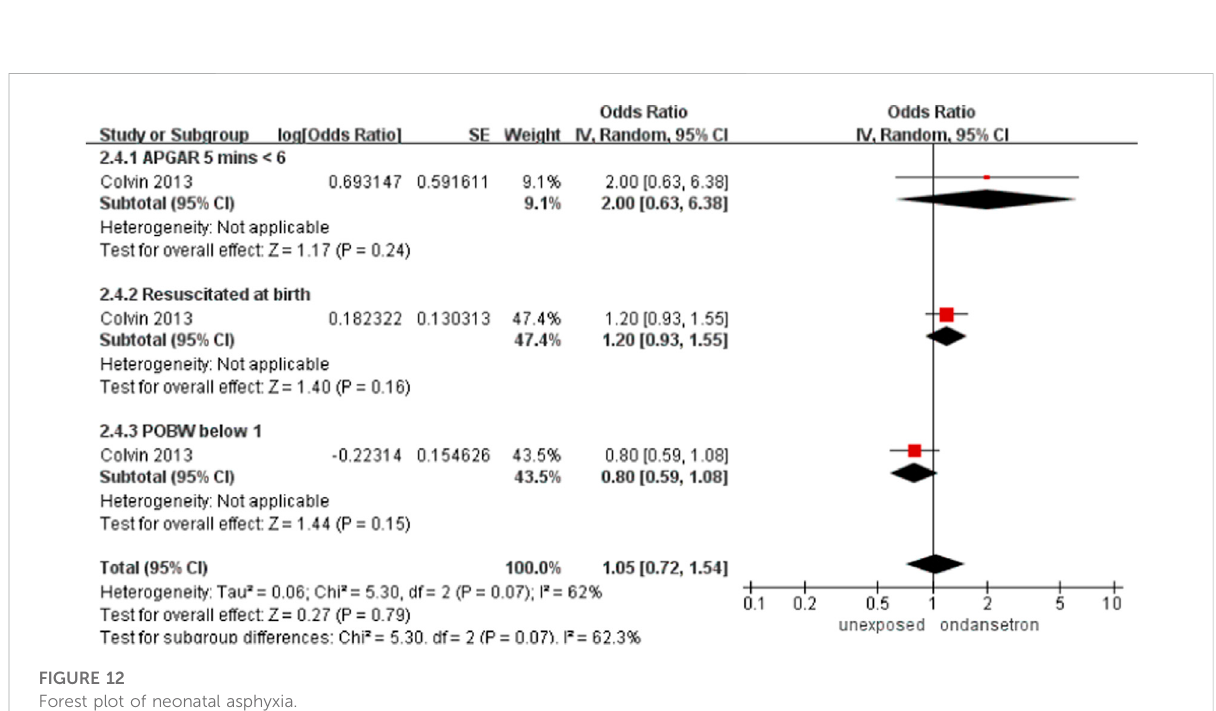
FIGURE 12 Forest plot of neonatal